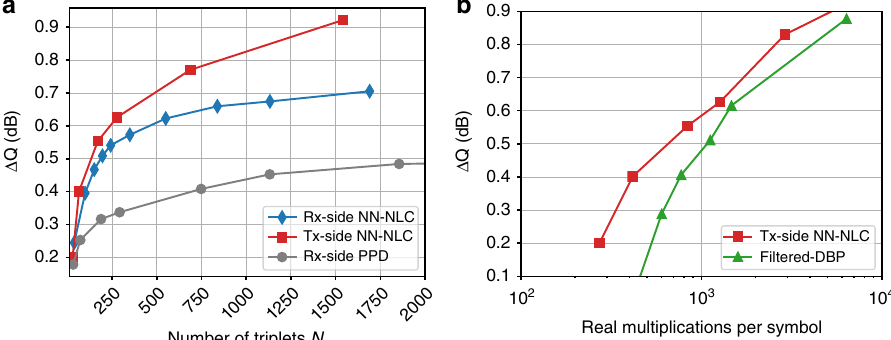
Fig. 9 The measured performance of the NN-NLC algorithm at 2800 km. a The comparison of Q-factor improvement between Rx/Tx-side NN-NLC and Rx- side PPD. b The comparison of Q-factor improvement between Tx-side NN-NLC and fi ltered-DBP versus the number of